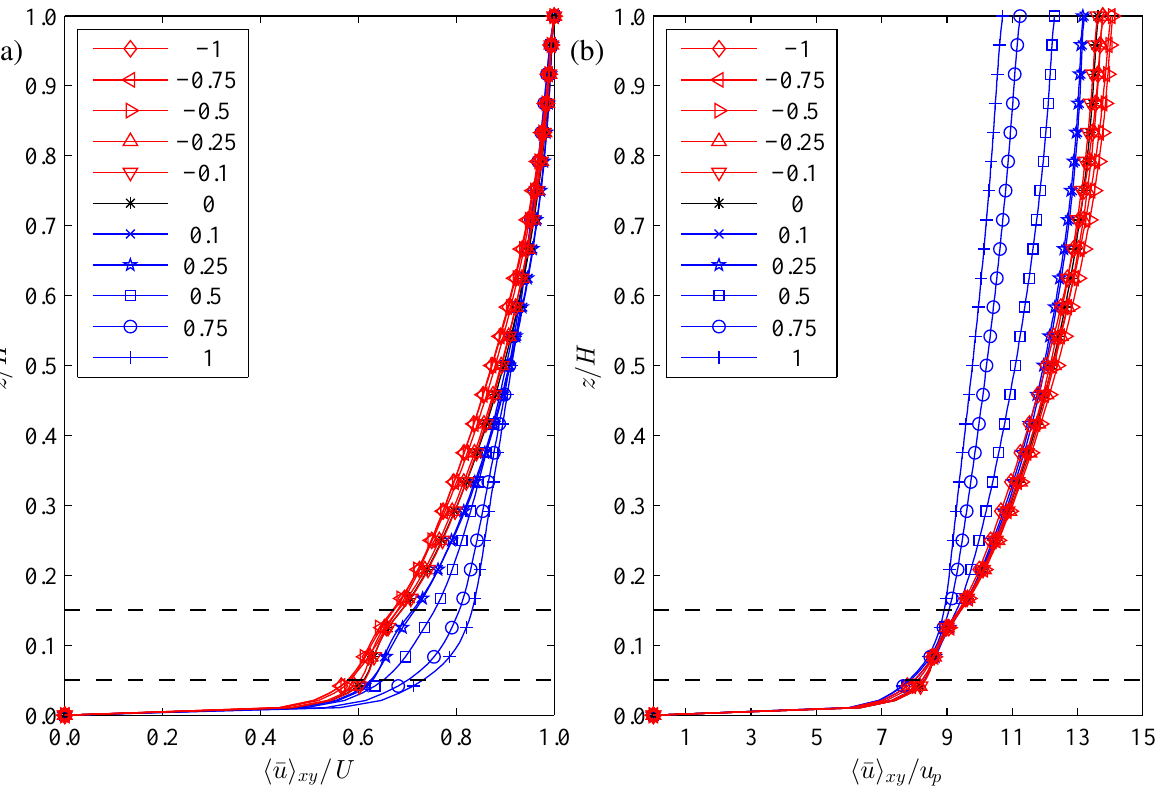
Figure 4. The time-averaged and horizontally-averaged streamwise velocity profiles are shown for all cases (with A given in the legend), normalized by ( a ) the velocity at the top of the domain and ( b ) the pressure forcing velocity scale. The turbines rotors are located between the horizontal dashed